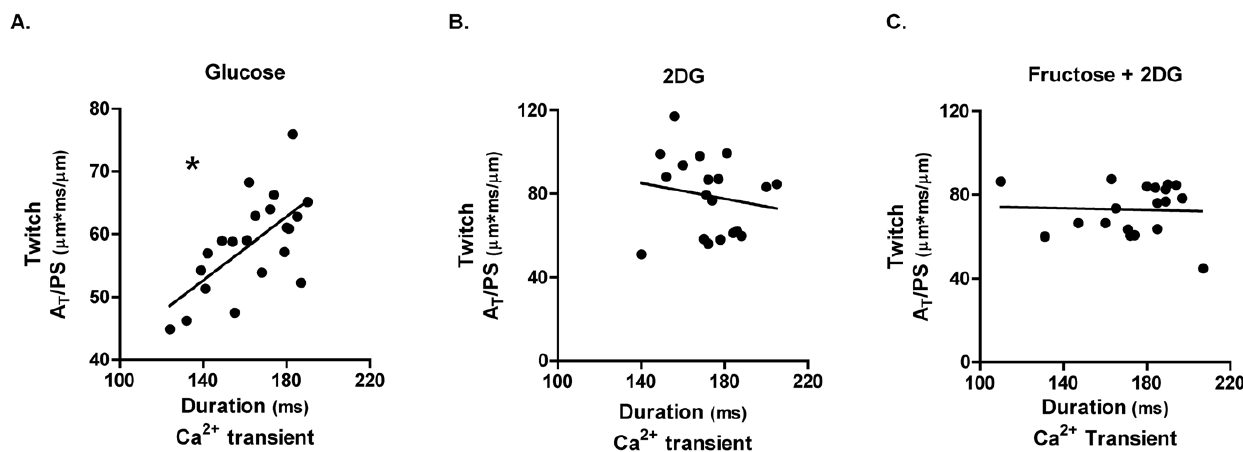
Figure 6. Altered myocyte shortening-Ca 2 + relationship. A. Correlation of area of the total twitch cycle normalized to peak shortening (A T /PS) and Ca 2 + transient duration for myocytes superfused under control glucose conditions (R 2 =0.416; *p , 0.05). B. Correlation of area of the total twitch cycle normalized to peak shortening (A T /PS) and Ca 2 + transient duration for myocytes superfused under 2 DG conditions (R 2 =0.028; p=ns). C. Correlation of area of the total twitch cycle normalized to peak shortening (A T /PS) and Ca 2 + transient duration for myocytes superfused under fructose + 2 DG conditions (R 2 =0.002; p=ns).